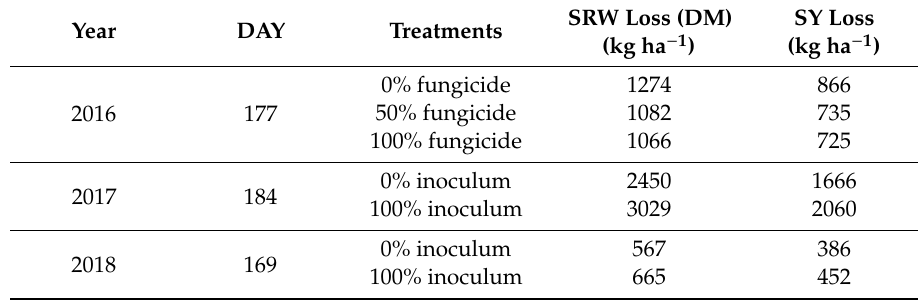
Table 10. Simulated storage root weight (DM) losses (SRW) (kg ha − 1 ) and corresponding sugar yield losses (SY) (kg ha − 1 ) at harvest as days after planting